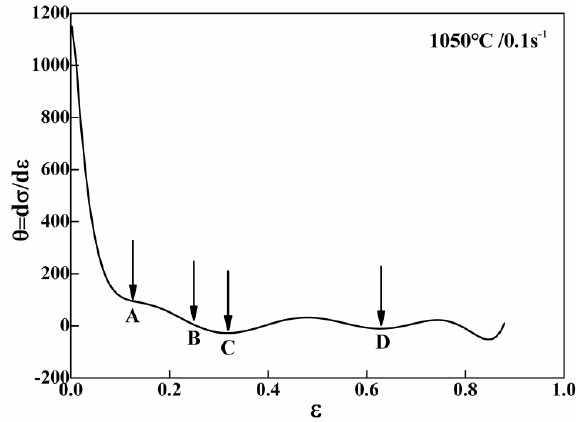
Figure 12. Relationship between θ and σ deformed at 1050 °C with 0.1 s −1 .